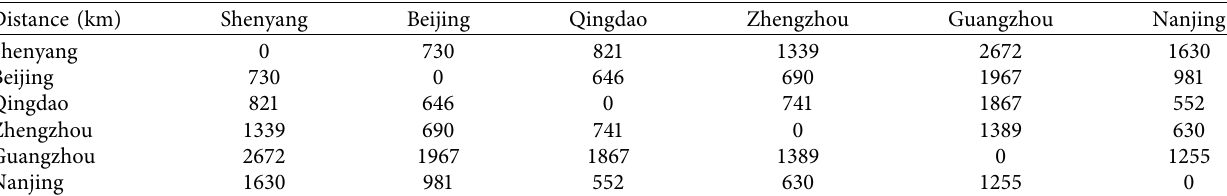
Table 1: Distance cost matrix.